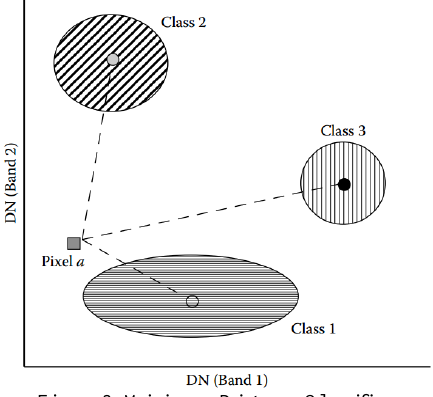
Figure 3. Minimum Distance Classifier.